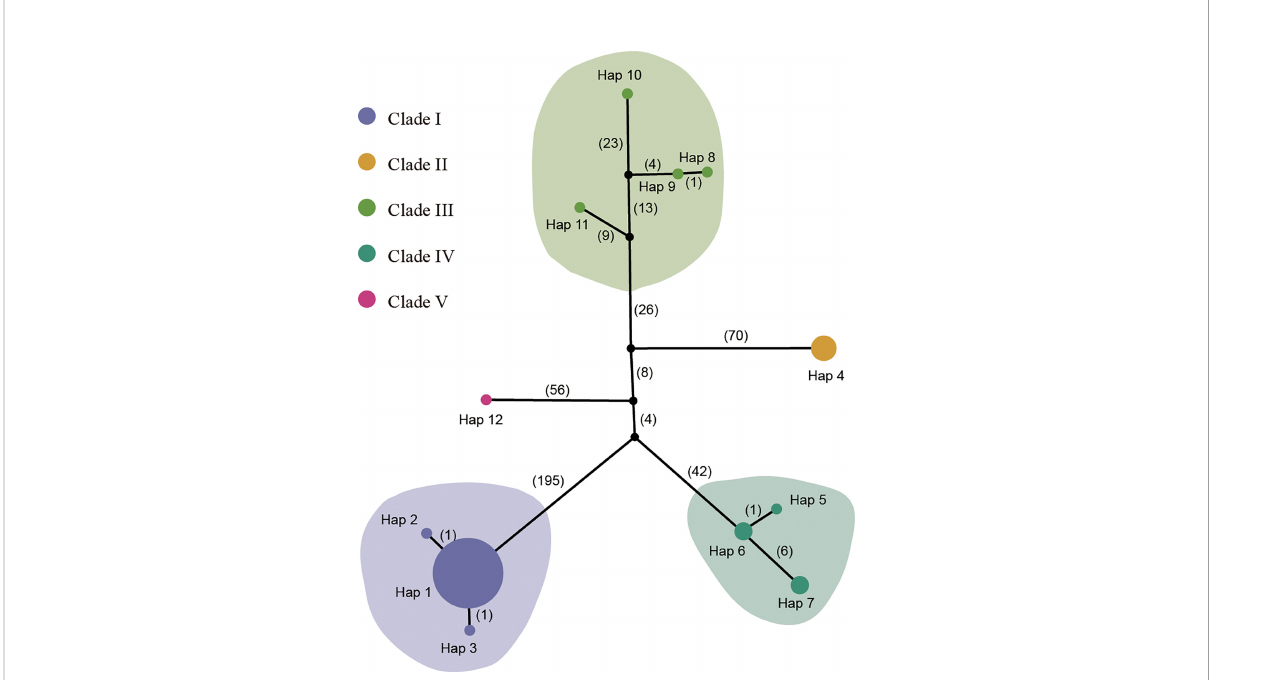
FIGURE 3 TCS network of 12 haplotypes from the plastome sequences. The colored circles represent plastid haplotypes; the black circles are extinct haplotypes; the number of mutational steps is shown on the lines. The size of the pie chart represents the number of the accessions. The haplotype for each sample is listed in Table